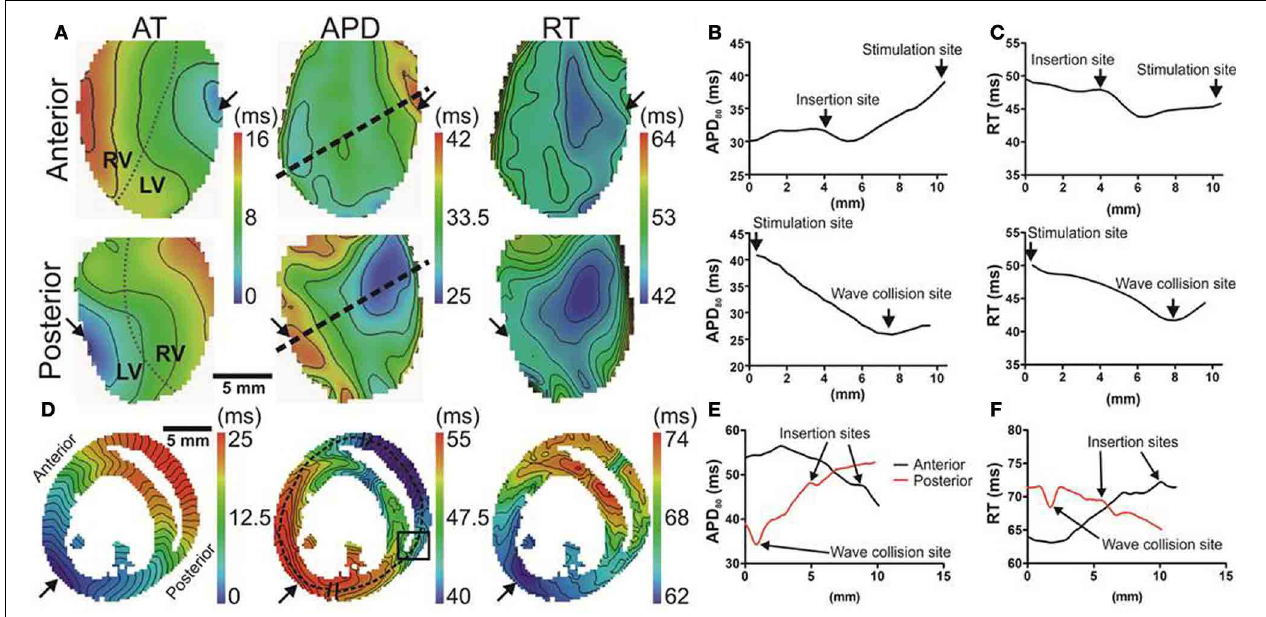
FIGURE 5 | Local modulation of APD in rat hearts by tissue architecture. (A) Hearts were simultaneously imaged from anterior (upper panels) and posterior (lower panels) views. Panels (from left to right) are AT and APD maps from ventricles paced at the mid left ventricular free wall (arrows). Insertion sites of left and right ventricular free walls are indicated by dotted lines in AT maps. Isochrones are spaced 2ms. Linear profiles of APD (B) and RT (C) measured from anterior (upper panel) and posterior (lower panel) surfaces. APD values